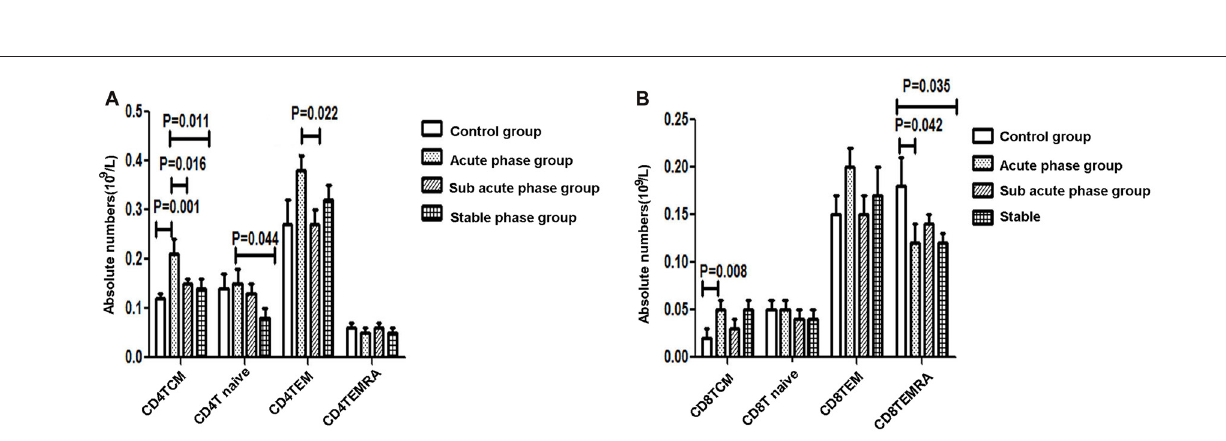
FIGURE 3 | (A) Quantitative analysis of differentiated CD4 + T cells in ischemic stroke groups and the control group. (B) Quantitative analysis of differentiated CD8 + T cells in ischemic stroke groups and the control group (comparisons between groups were performed via one-way ANOVA, and a post hoc test was used to determine differences between groups. Graphs show the mean + SEM; Control group ( n = 14), Acute phase group ( n = 18), Sub-acute phase group ( n = 31), Stable phase group ( n =